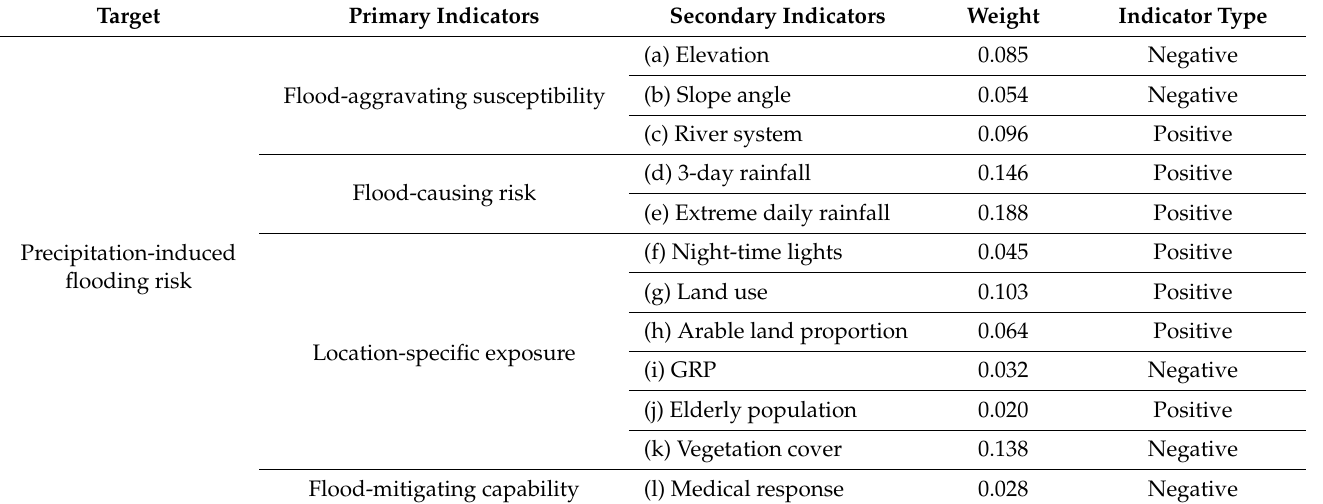
Table 3. Index weights for precipitation-induced flooding risk assessment.